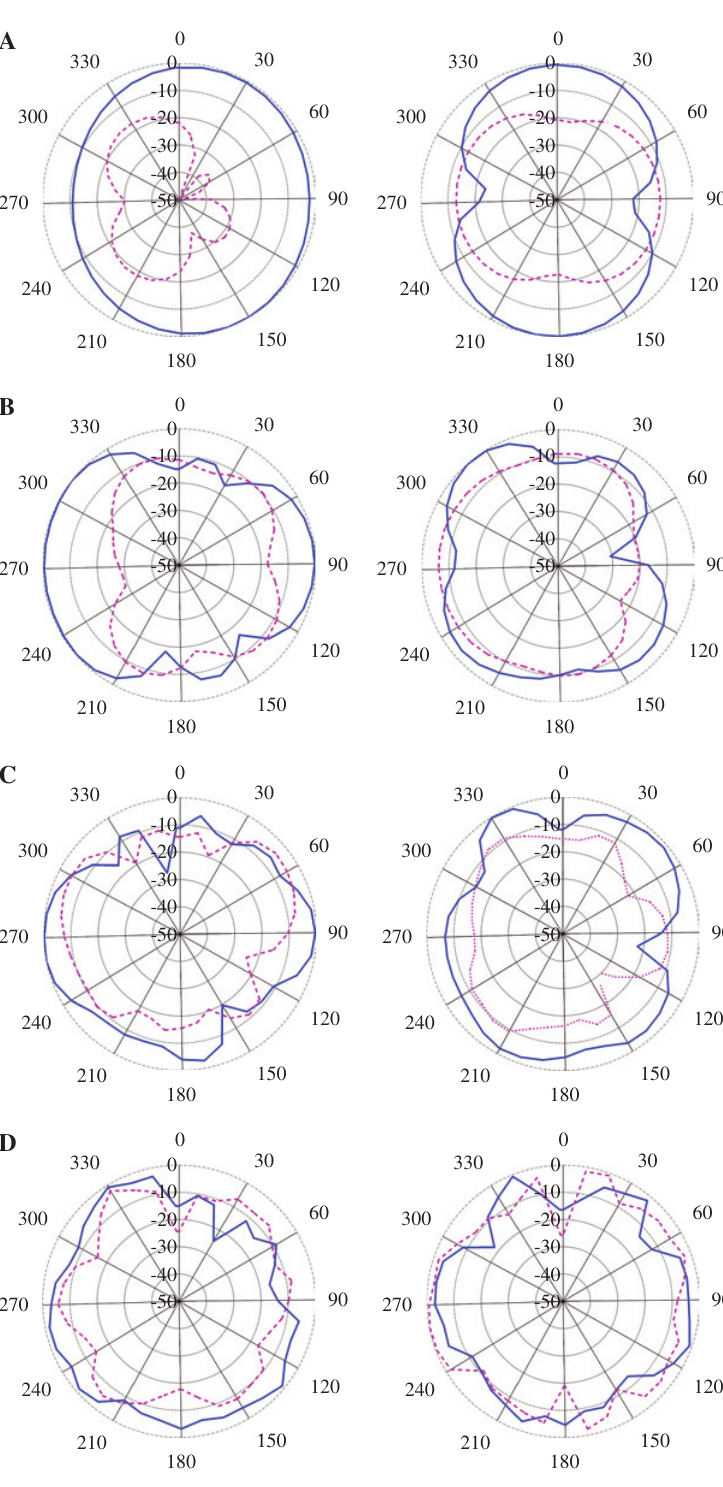
Figure 9: Measured radiation pattern at (A) 4 GHz, (B) 8 GHz, (C) 12 GHz, and (D) 16